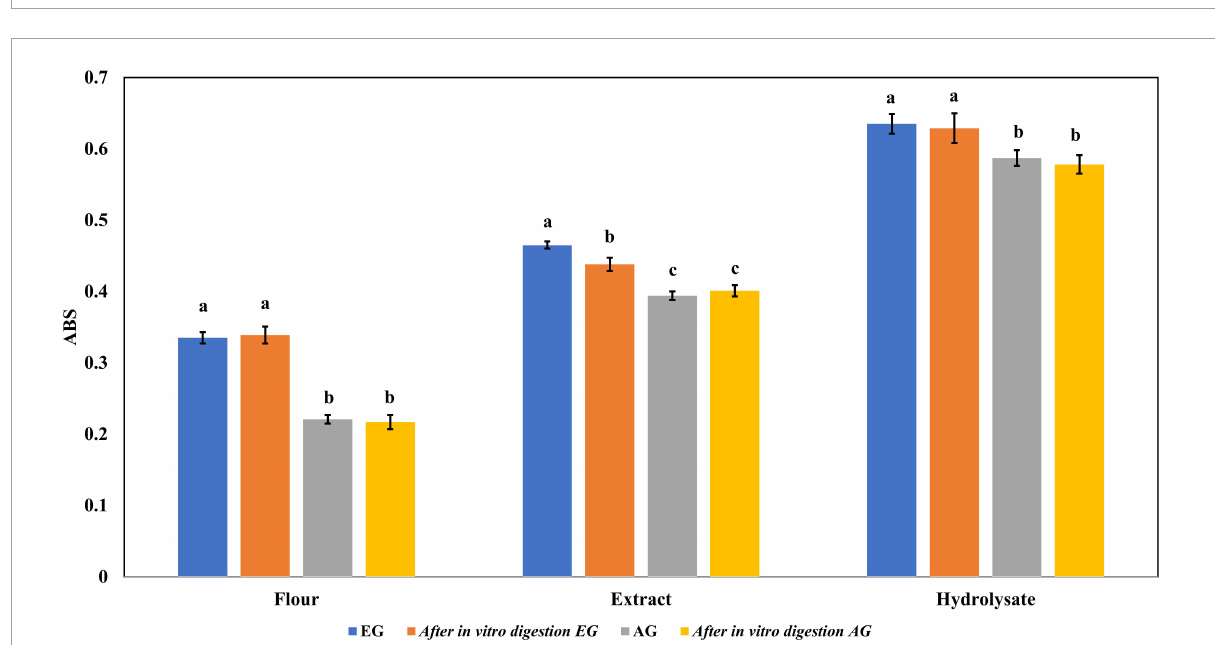
FIGURE8 Ferric reducing antioxidant power of flour, extracts, and hydrolysates of early grasshopper (EG) and adult grasshopper (AG) comparing before and after in vitro protein digestion. Results are reported in absorbance units at 700 nm. Different letters between bars indicate a significant difference ( p -value <